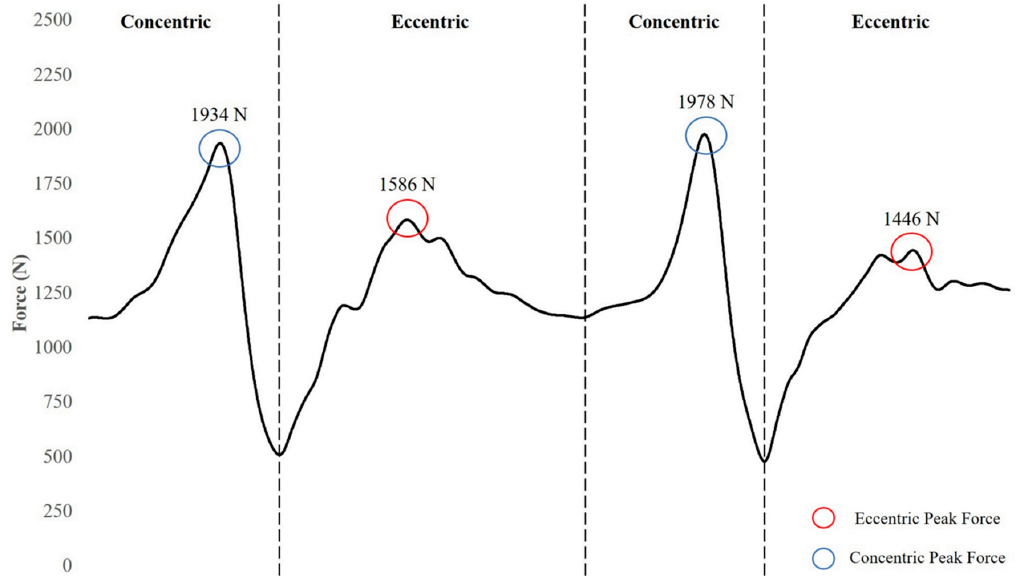
Figure 3. Force–time curve of flywheel squats performed by a healthy, 31 year old male using a 0.050 kg ∙ m 2 inertial load with a fast concentric action (< 1 s) and a slow eccentric action (~ 2 s).